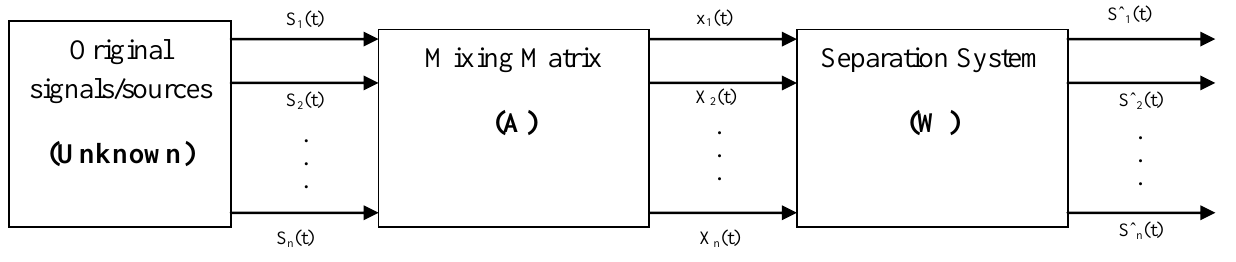
Figure 6. Blind source separation (BSS) block diagram